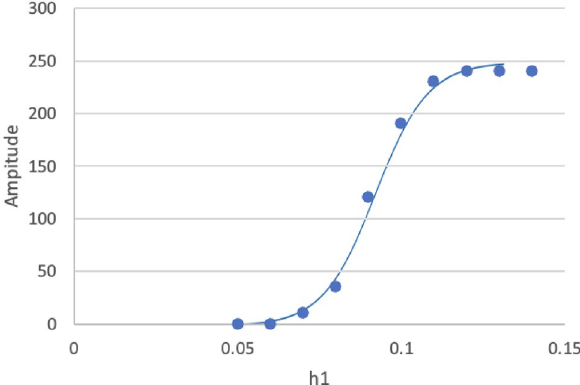
Figure 5. Plot of the amplitude of the infection wavy oscillation. The wavy amplitude of the infection number is plotted in reference to the diffusion coefficient h 1 . The vertical scale represents the date from the first day of the infection report. The line is fitted to a sigmoid function to the plot using the fitting algorithm of